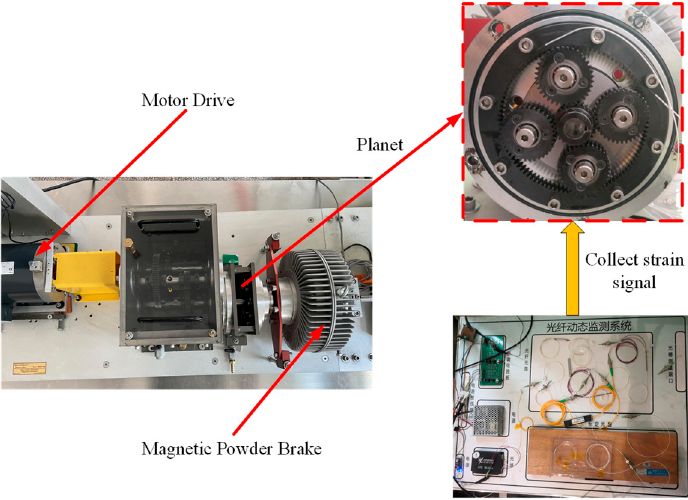
Figure 11. Wind turbine test bench and signal acquisition system.